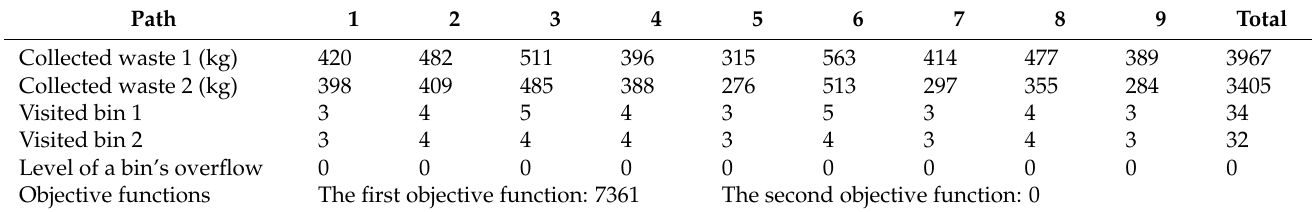
Table 2. Results by